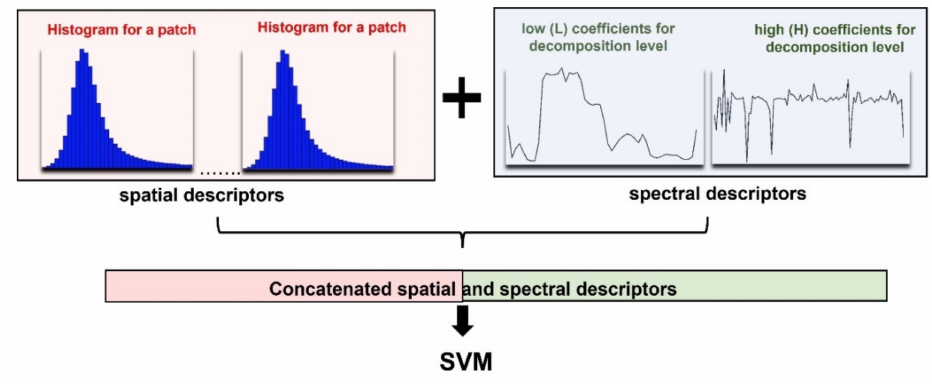
Figure 6. Feature vector used in classification composed of spatial and spectral